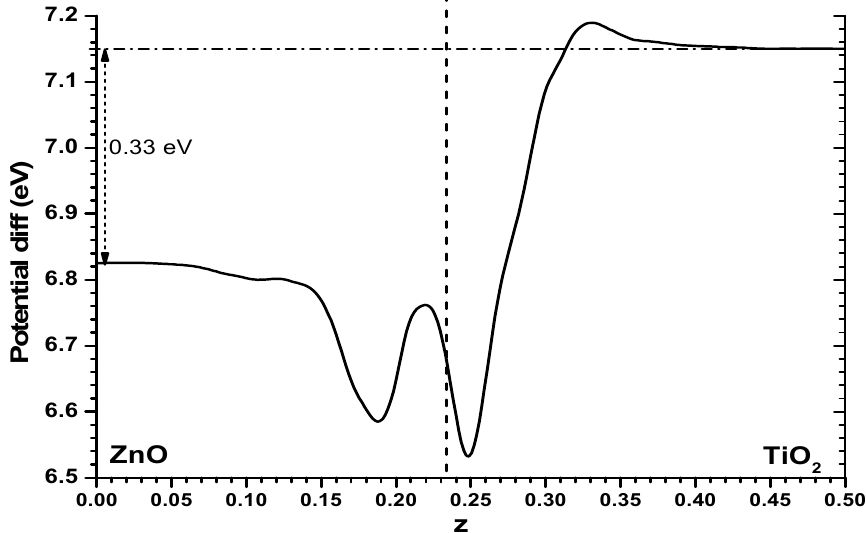
Figure 4. Band offsets found for the interface between ZnO and anatase TiO 2 .